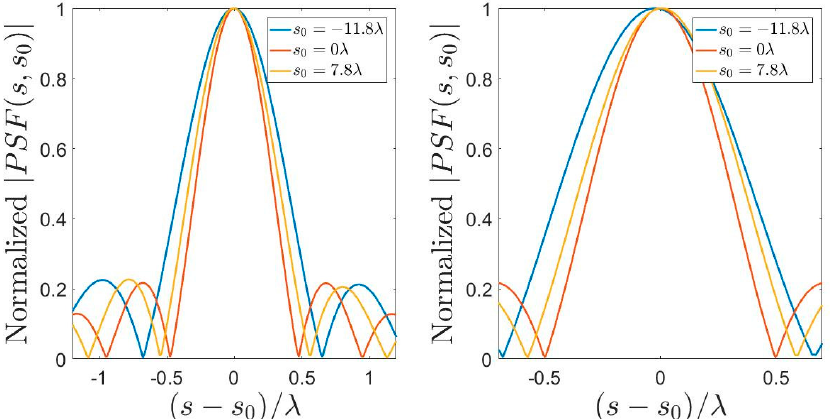
Figure 7. Normalized and overlapped PSFs of L θ (left panel) and L u (right panel) operators of a semi-circumference source with a x = 10 λ plotted in function of the arc length variable (the s 0 values are computed in correspondence to the φ 0 and ξ 0 used in Figure 6).